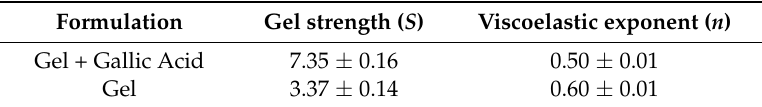
Table 3. Gel strength ( S ) and viscoelastic exponent ( n ) of both gel (gel) and GA-loaded gel (gel + gallic acid).